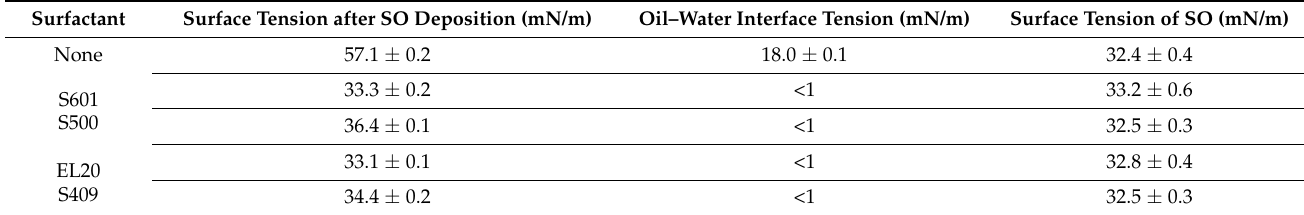
Table 1. Surface tension of water subphase and oil–water interface tension after deposition of spreading oil (SO) containing different kinds of surfactants. Surface tension of a variety of SO. Surfactant